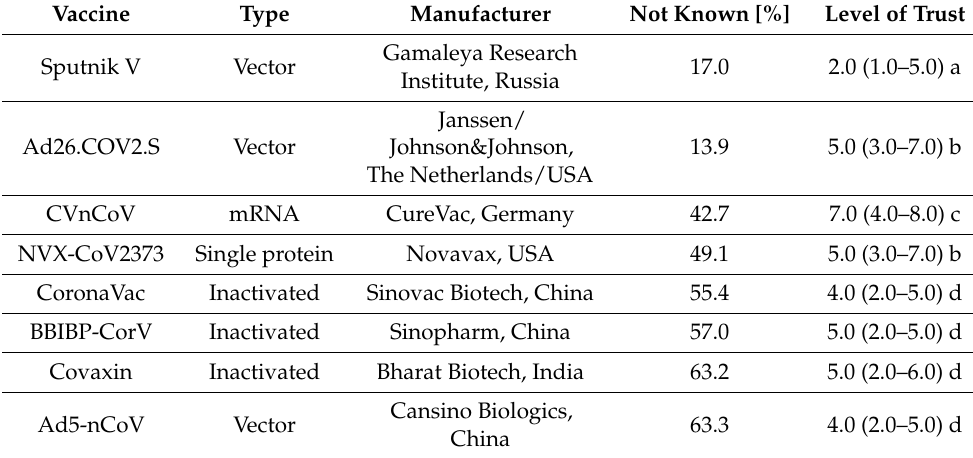
Table 4. The level of trust (evaluated using 10-point Likert-type scale; median and interquartile range) in the COVID-19 vaccines not authorized in the European Union at the time of the study but in use in other world regions or in advanced stages of clinical trials ( n =